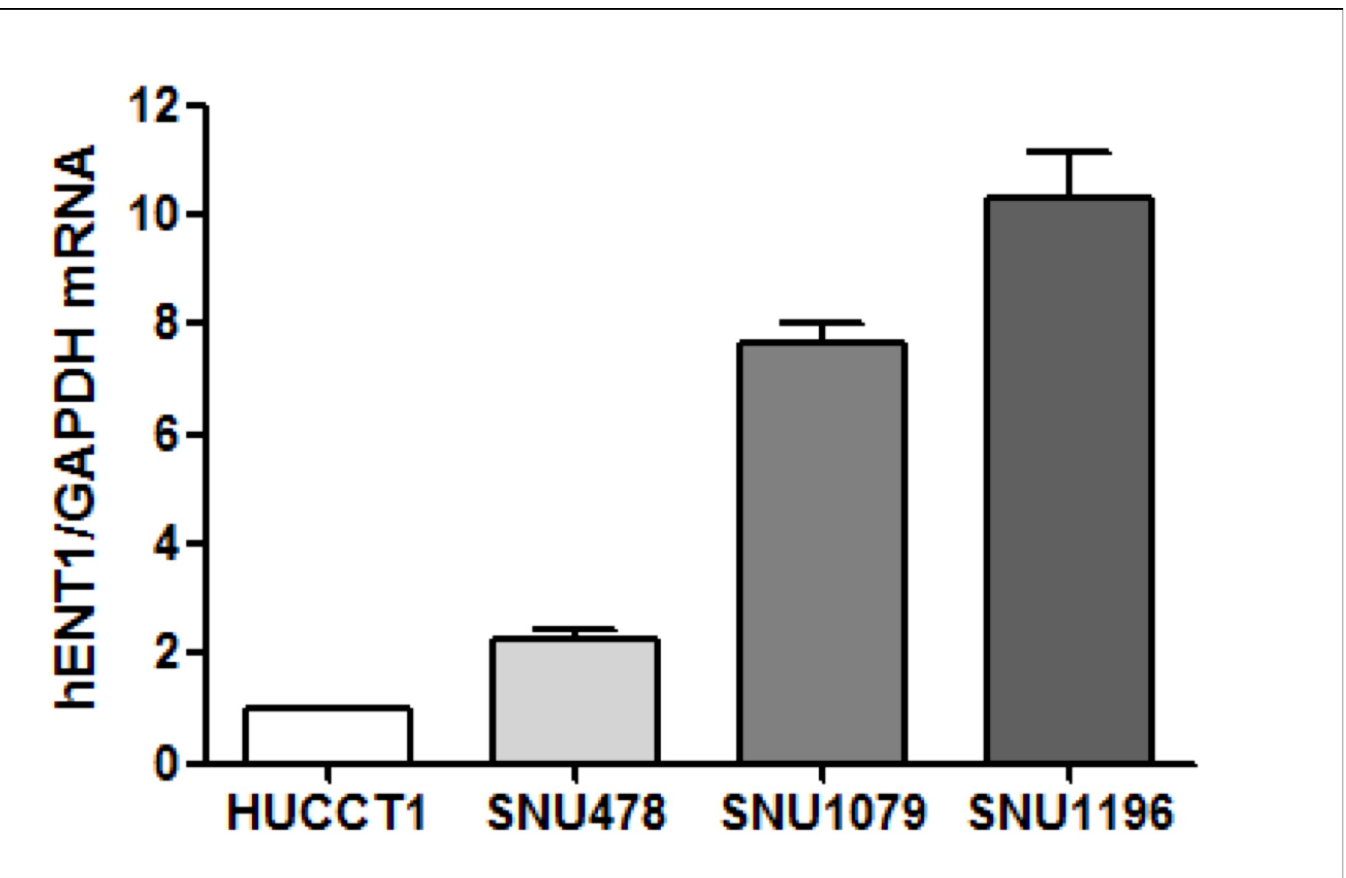
Fig 1. Expression of hENT1 mRNA. Baseline levels of mRNA expression of hENT1 were measured relative to those of HuCCT1 cells by quantitative RT-PCR. SNU1196 showed the highest mRNA expression of hENT1 .